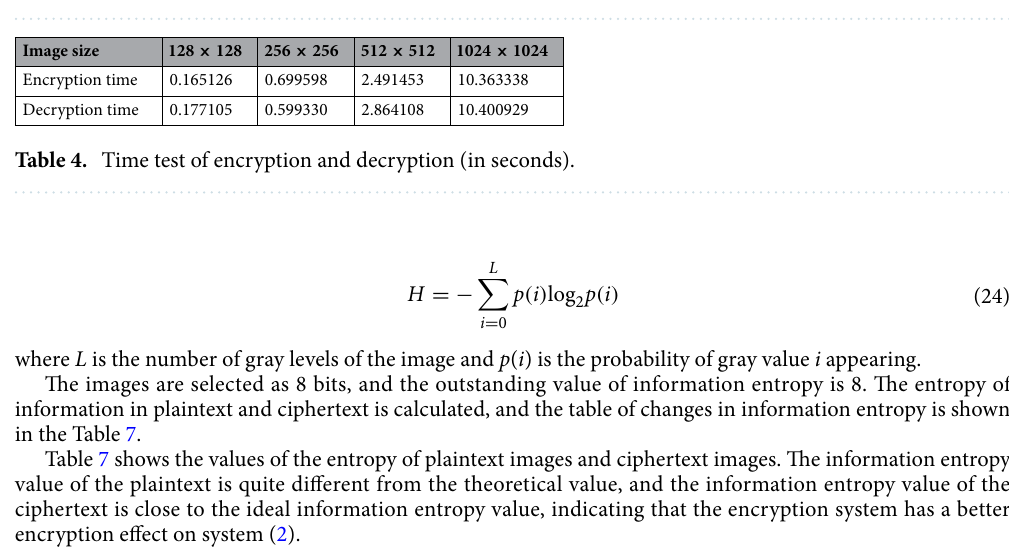
Figure 14. Plaintext images, encrypted images, decrypted images, and histograms of Brick Wall, Sand, Motion, Grass, and Toy Vehicle. ( a ) Plaintext images. ( b ) Histogram of the plaintext images. ( c ) Encrypted images. ( d ) Histogram of the encrypted images. ( e ) Decrypted images.